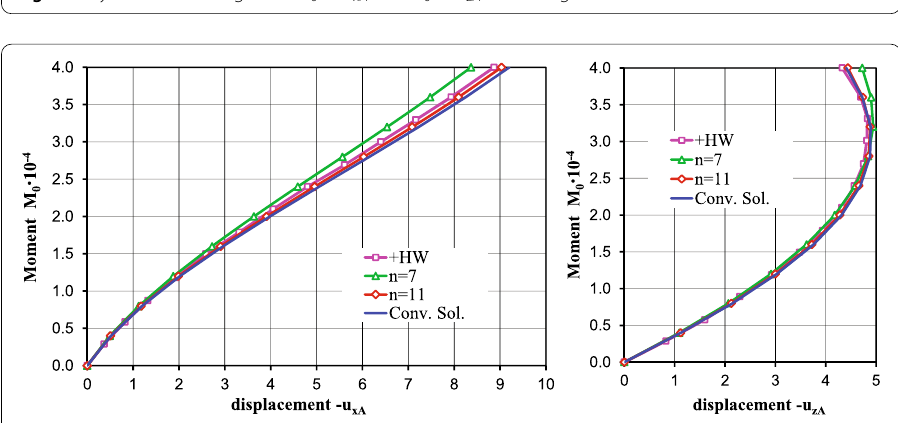
Fig. 13 Cylindrical shell segment: M 0 − u xA and M 0 − u zA for the regular 12 × 12 mesh